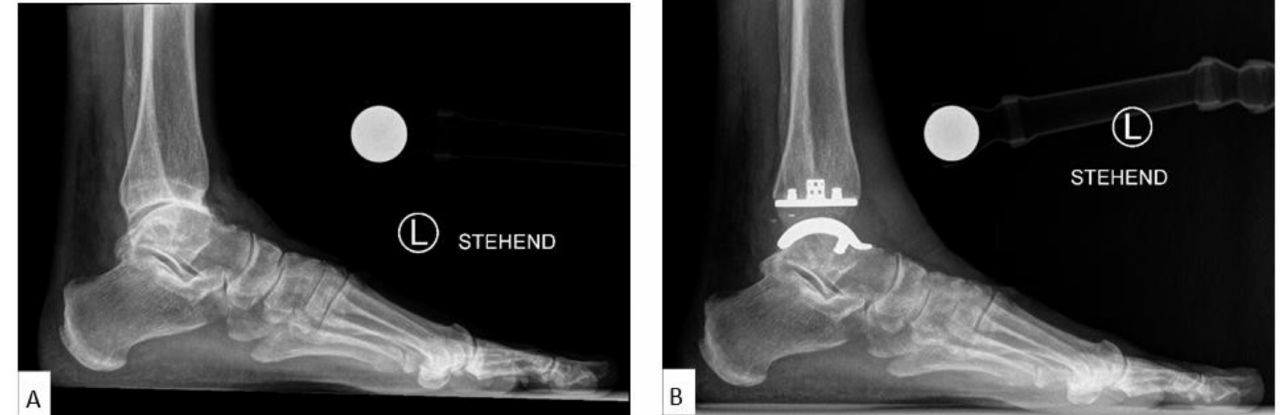
Figure 3. Case with Centralization of Talus after Implantation of VANTAGE Mobile Bearing Total Ankle Arthroplasty. The talar centre of rotation/Lateral Talar Station (LTS) converged toward the longitudinal tibial axis from 10 mm preoperatively ( A ) to 2 mm postoperatively in 12 months follow-up radiograph ( B